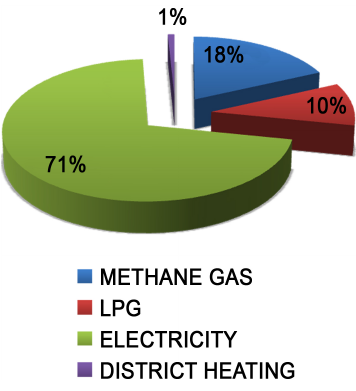
Figure 7. Energy consumption by energy carrier – Industry